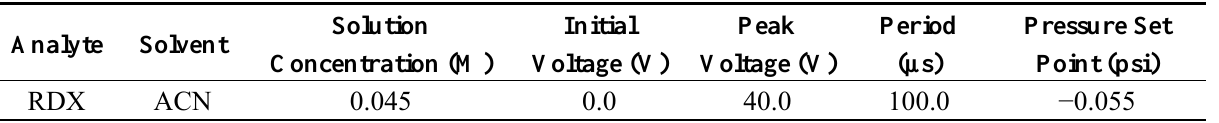
Table 2. Sinusoidal waveform parameters for an optimal RDX drop using ACN with a 60 µm dispensing device